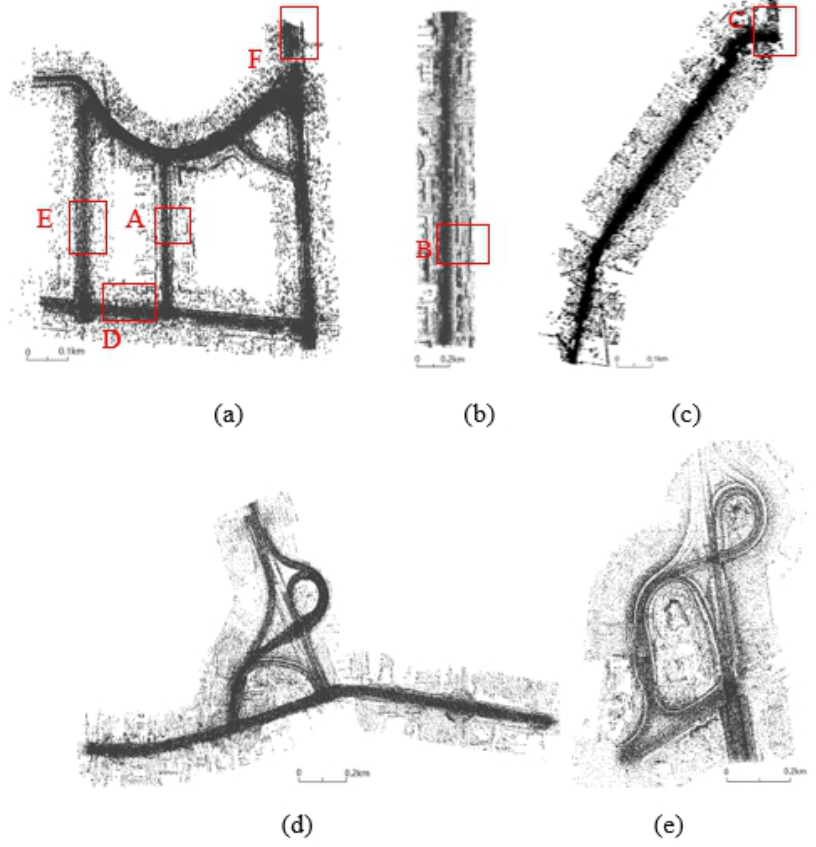
Figure 8. Experimental datasets of a suburban area from Tianjin ( a ), an urban area from Beijing ( b ), a rural area from Lianjiang ( c ), and structural ( d ) and non-structural ( e ) highway ramps in